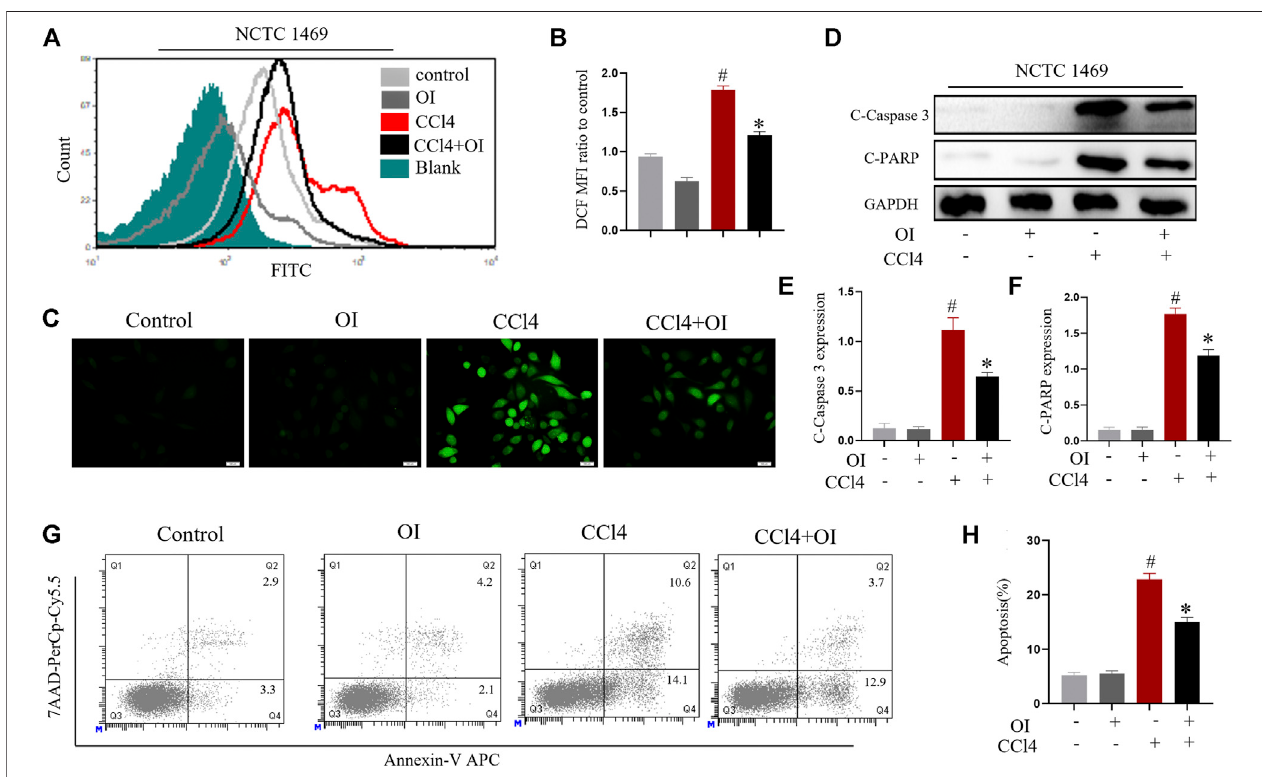
FIGURE4| OIattenuatedCCl4-inducedcelldeathandROSlevelsinNCTC1469cells. (A) HistogramofDCFFITC fl uorescence. (B) Mean fl uorescenceintensityof DCF ofeach group. (C) NCTC 1469 hepatocytes were stainedwithDCFH-DA probe, and representative images werecaptured. (D) OIreduced increased levels ofpro- apoptotic cleaved caspase-3 and cleaved PARP induced by CCl4 in each group, and we then performed an analysis (E,F) . (G) OI diminished the increased death of hepatocytesNCTC 1469causedbyCCl4, and wethenperformedananalysis (H) . Gapdh wasused asan endogenous control. Originalmagni fi cation, × 400.Data are expressed as mean ± SEM. All experiments were performed three times independently. # p < 0.05 vs. control group; * p < 0.05 vs. CCl4-treated